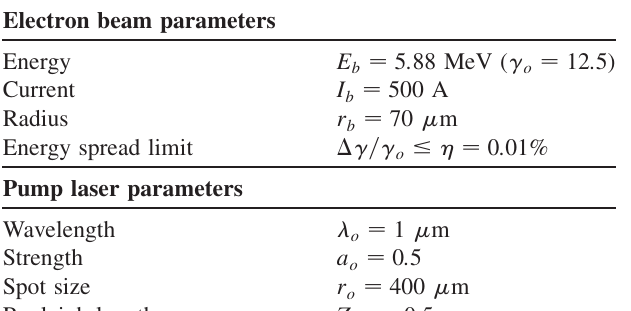
LASER-PUMPED COHERENT X-RAY . . TABLE I. Parameters for a laser-pumped FEL. Electron beam parameters Energy Current